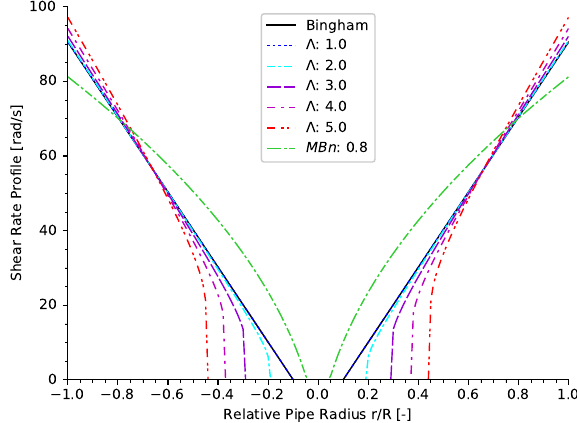
Figure 4: An increased flow rate Q of 10 L / s ( ̂︀ Q = 2.18 with R = 52.65 mm ) reveals a shifting equilibrium between shear action and thixotropic structure build-up. Again, the plug zone (region where ˙ 𝛾 = 0 ) also increases with an increasing thixotropy factor Λ